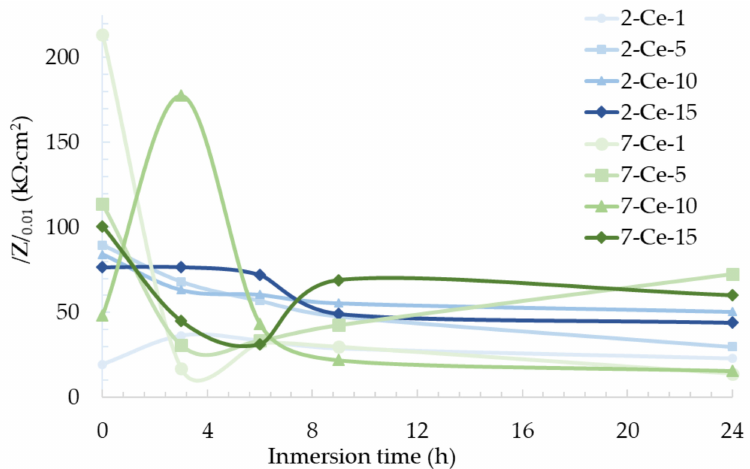
Figure 8. /Z/ 0.01 during the immersion test in 0.5%